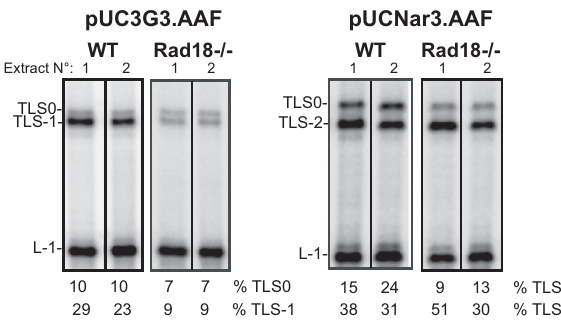
Figure 3. Analysis of Rad18 dependence of the G-AAF bypass in HCT116 cell-free extracts. HCT116 cell-free extracts, wild-type (WT) and Rad18 2 / 2 (20 mg), were incubated 30 min at 37 u C in the presence of 10 fmoles of AAF-modified substrates either at the 3G sequence or at the NarI site in a final volume of 6.25 ml, as indicated. The samples were analysed by electrophoresis through a 8% de- naturing polyacrylamide gel. L-1 is a product generated if synthesis is blocked one nucleotide before and opposite the lesion, respectively. TLS0 and TLS-1 or –2 are products from TLS via non-slipped and slipped intermediates, respectively.Quantitative analysis of experiments with two independent extracts are presented.